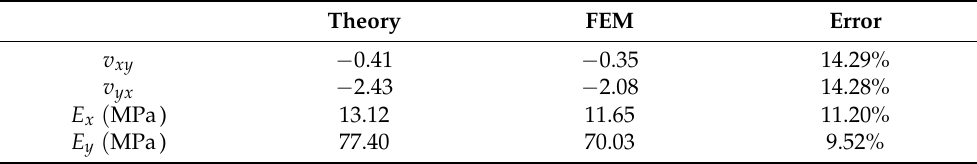
Figure 3. Stress and displacement cloud diagrams of E-antitet cell: ( a ) Stress and ( b ) displacement cloud of the cell under axial compression; ( c ) stress and ( d ) displacement cloud of the cell under transverse compression. Table 1. Comparison of the results of theoretical derivations and FEM